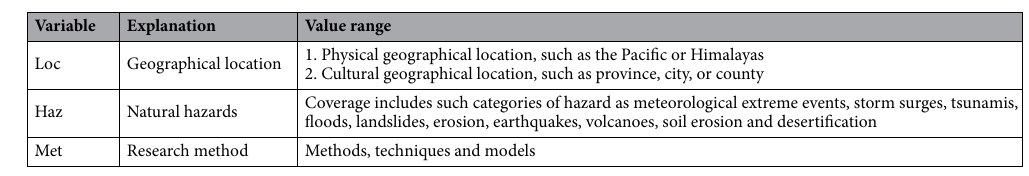
Table 2. Description of variables in the annotation